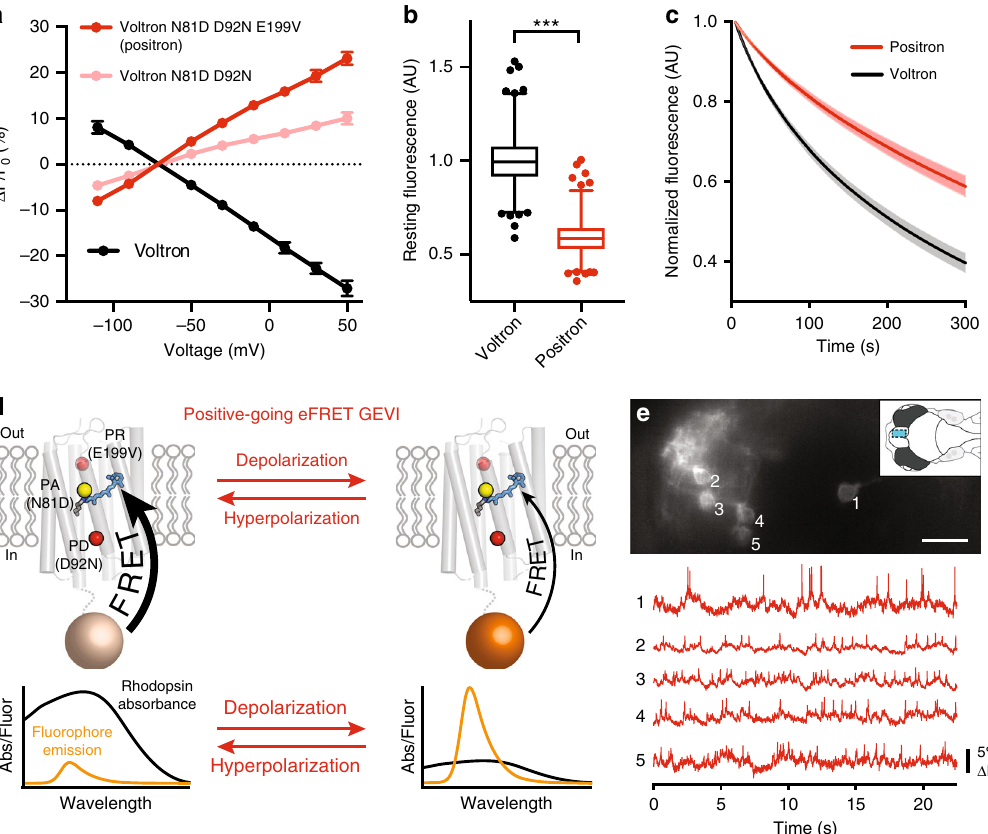
Fig. 2 Characterization of positron neuron culture and larval zebra fi sh. a Graph of fl uorescence vs. membrane voltage for Voltron ( N = 6 cells), Voltron D92N N81D ( N = 5 cells), and Positron ( N = 5 cells) expressed in voltage-clamped rat hippocampal neurons in culture. Δ F / F 0 measurements are mean ± SD. b Box and whisker plot showing the fl uorescence of Voltron and Positron at resting membrane potential in neuron culture. Box represents interquartile range, center represents median, and whiskers represent 1st – 99th percentile. Outliers shown as dots. N = 633 cells and 686 cells. *** P < 0.001 for two- tailed unpaired t -test. c Comparison of photobleaching of Positron and Voltron. Mean normalized fl uorescence from a fi eld of view of labeled, GEVI- expressing neurons is shown ±SEM. N = 19 fi elds of view each from N = 4 independent neuron cultures each. d Schematic representing the proposed mechanism of positive-going rhodopsin eFRET GEVIs. Spectra 14 in the lower panels have been scaled to illustrate the direction of absorbance and fl uorescence change with membrane voltage change. We were not able to quantitatively measure these spectra in cell membranes at different voltages. At resting membrane potential, rhodopsin absorbance is high and therefore fl uorophore emission is quenched. When the membrane depolarizes, rhodopsin absorbance decreases leading to an increase in fl uorophore emission. e Imaging of voltage signals from fi ve neurons in the forebrain of live larval zebra fi sh. (top) Imaged fi eld of view showing fl uorescence from fi ve individual neurons expressing Positron and labeled with JF 525 . Inset shows an overview of the larval zebra fi sh brain and the imaged area (blue rectangle). (bottom) Fluorescence of the fi ve visible neurons over time. Scale bar: 20 μ m Data are representative of N = 3 fi